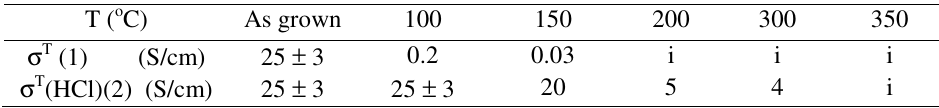
Table 1. Effect of thermal treatment on dry state electrical conductivity of polyaniline membranes prepared chemically and casted from NMP T ( o C) As